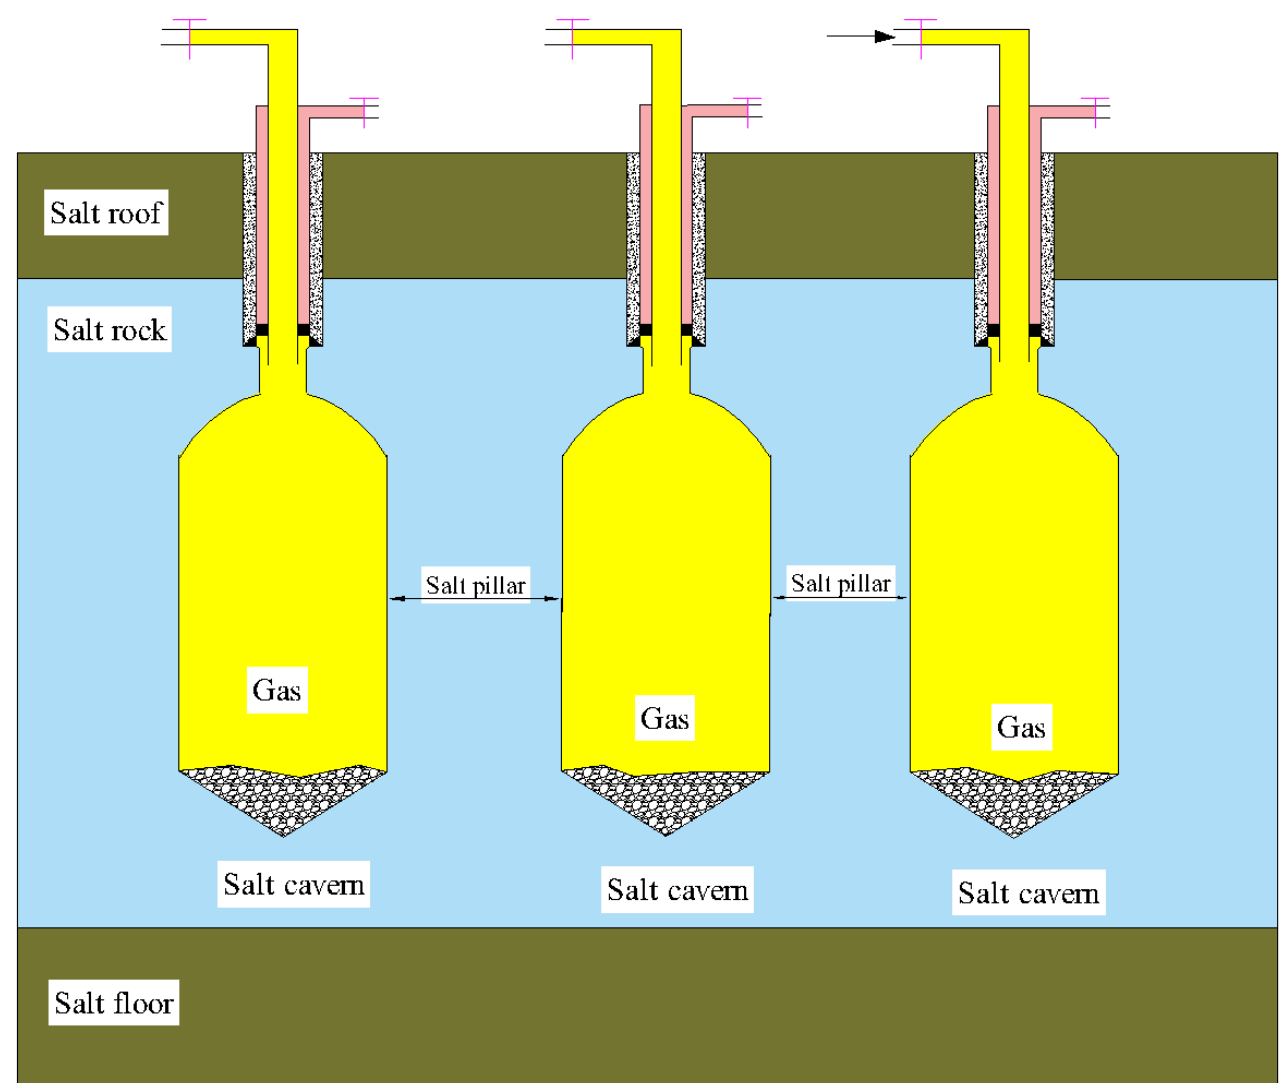
Figure 1. Two salt pillars between salt caverns.